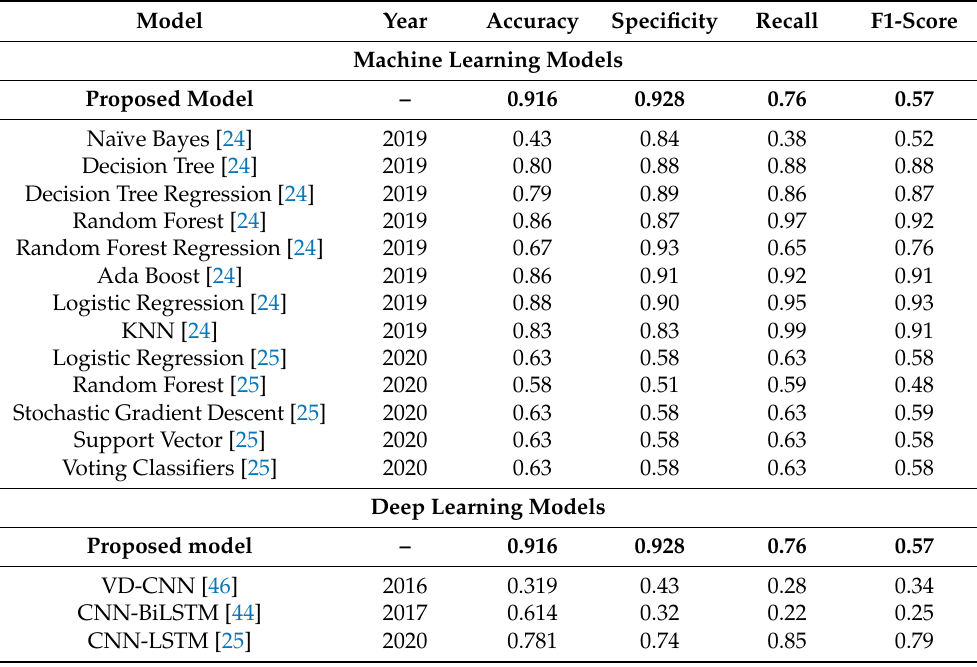
Table 2. Comparison with previous artificial neural network